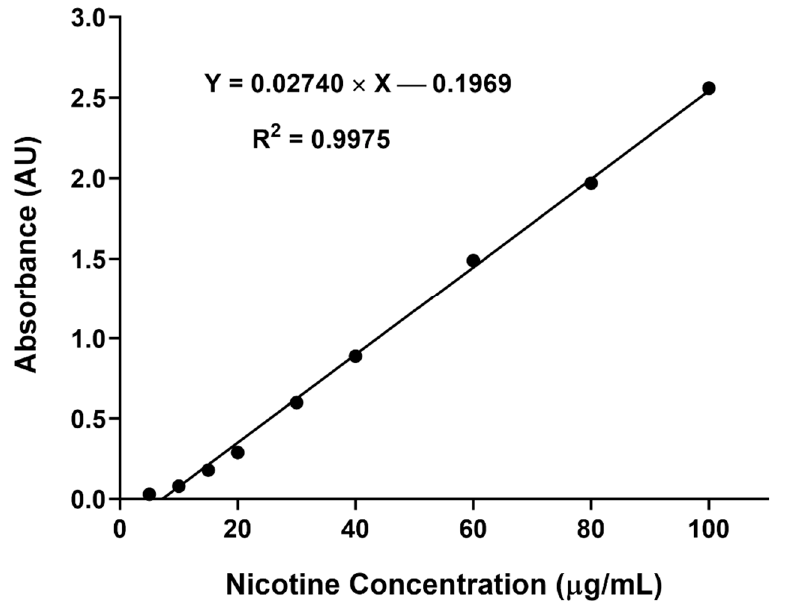
Figure 6. Nicotine calibration curve demonstrating acceptable linearity of absorbance at 258 nm against concentration over the range of 10 to 100 µg/mL (n = 3).